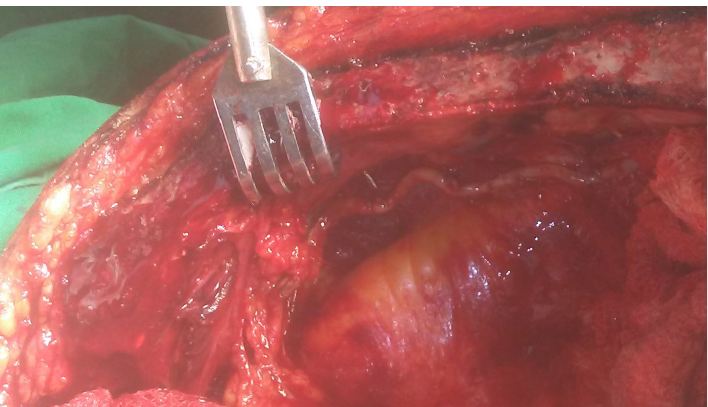
Fig. 5 - Considerable dilation of the middle segment of the left ITA during the harvesting with its distal end